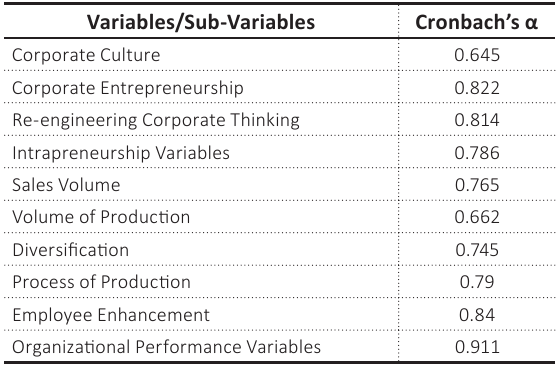
Table 2. Reliability test